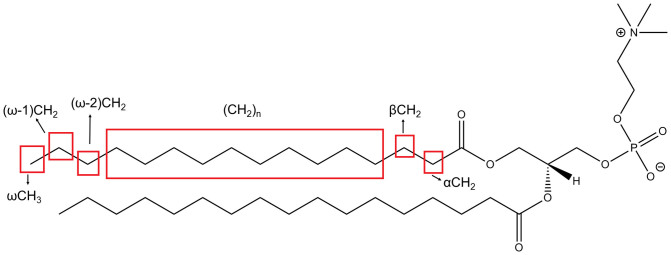
Structure of dipalmitoylphosphatidylcholine (DPPC) phospholipid.The phospholipid structure shows the positions of various methylene (CH2)n, (ω-1)CH2, (ω-2)CH2, αCH2 and βCH2 and methyl ωCH3 groups. These signatures are detected in the NMR experiments. The structure is shown as a model example to understand the different peaks in the NMR results.